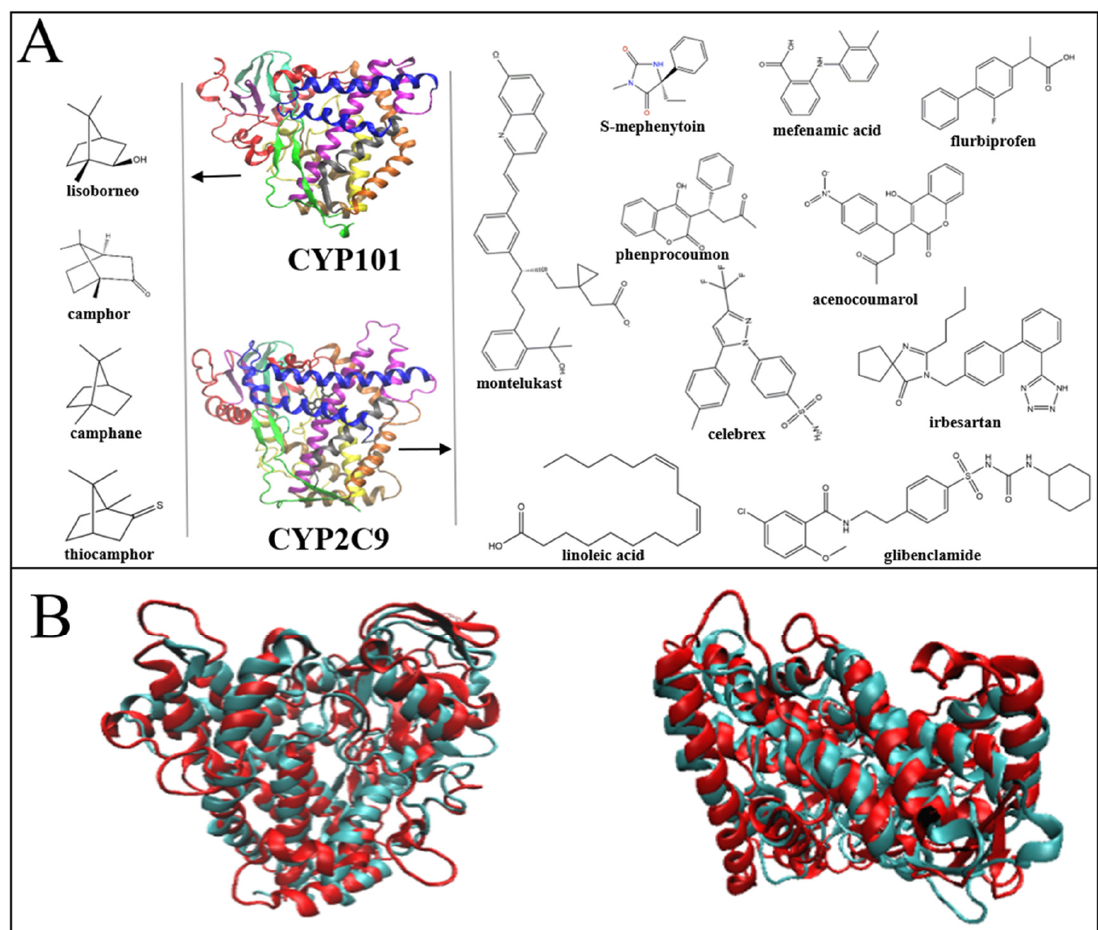
Figure 1. Comparison of the structures and ligands of CYP101 and CYP2C9. ( A ) Comparison of substrate specificities between CYP101 and CYP2C9. The substrates of CYP2C9 contain many different small molecules, long-chain polyunsaturated fatty acids and high molecular weight aromatic compounds, while CYP101 only catalyzes a limited number of small compounds, mostly camphor and camphor derivatives. ( B ) Superposition of the backbones of bacterial CYP101 (cyan, PDB 1DZ9) with that of the human CYP2C9 (red, PDB 5XXI) from the top view (left) and the side view